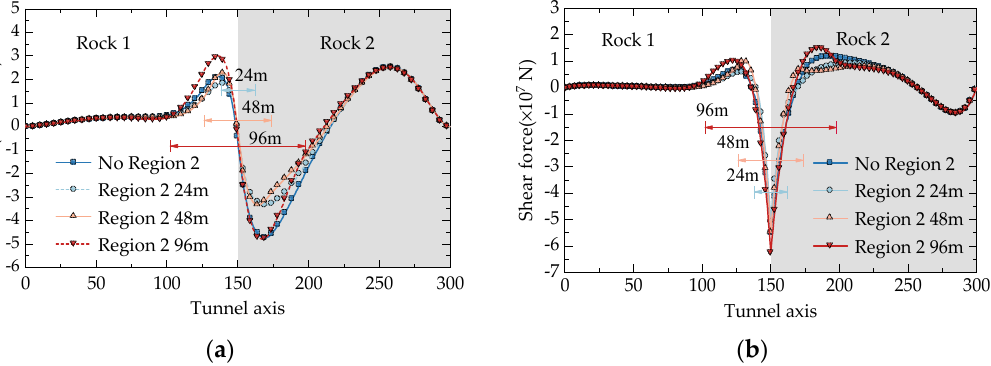
Figure 8. Effect of the length of the transition zone on internal forces. ( a ) Bending moment; ( b ) shear force.